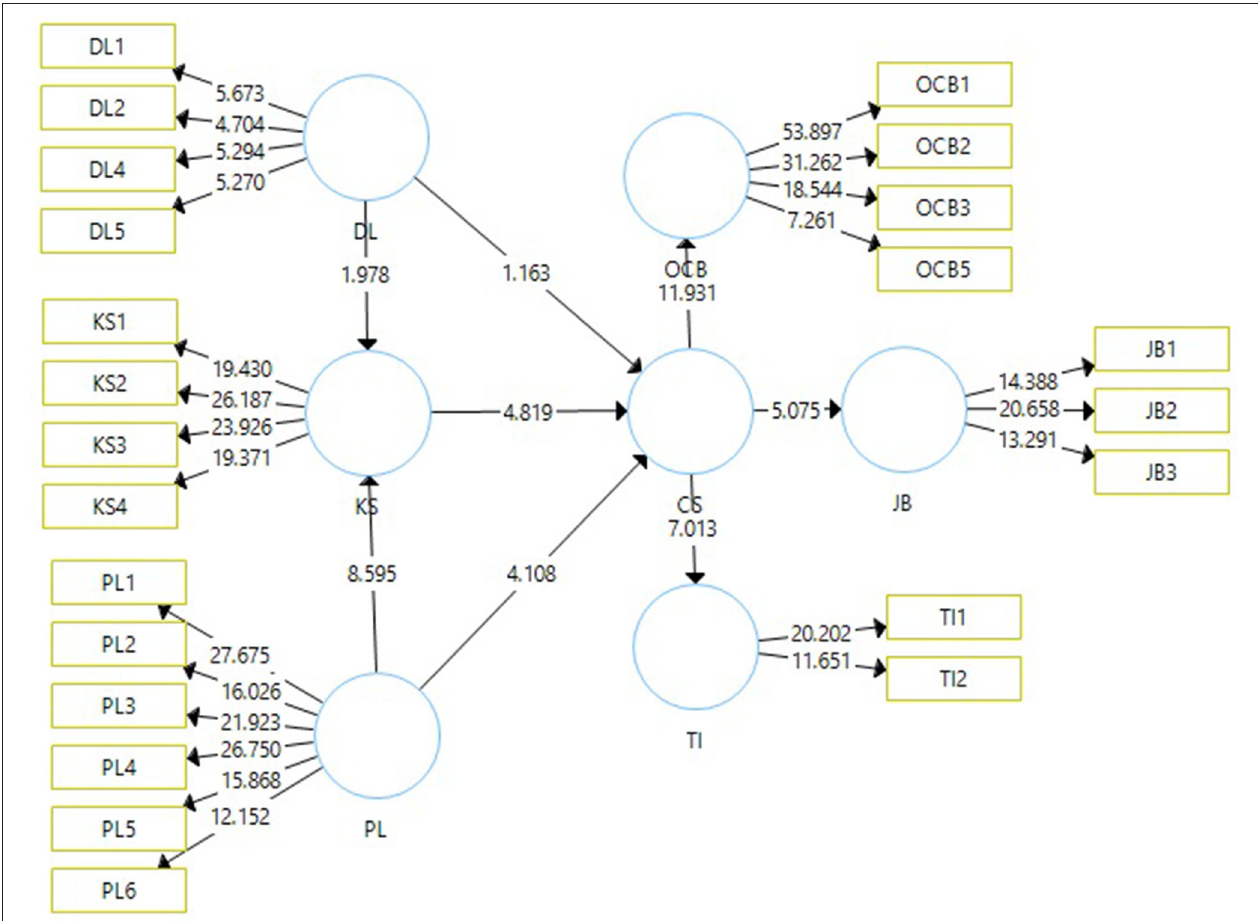
FIGURE 2 | Discriminant validity was assessed as a part of the construct validity, as the multiple items used to measure the same construct should be in agreement, while items between different constructs should be distinct ( Campbell and Fiske,